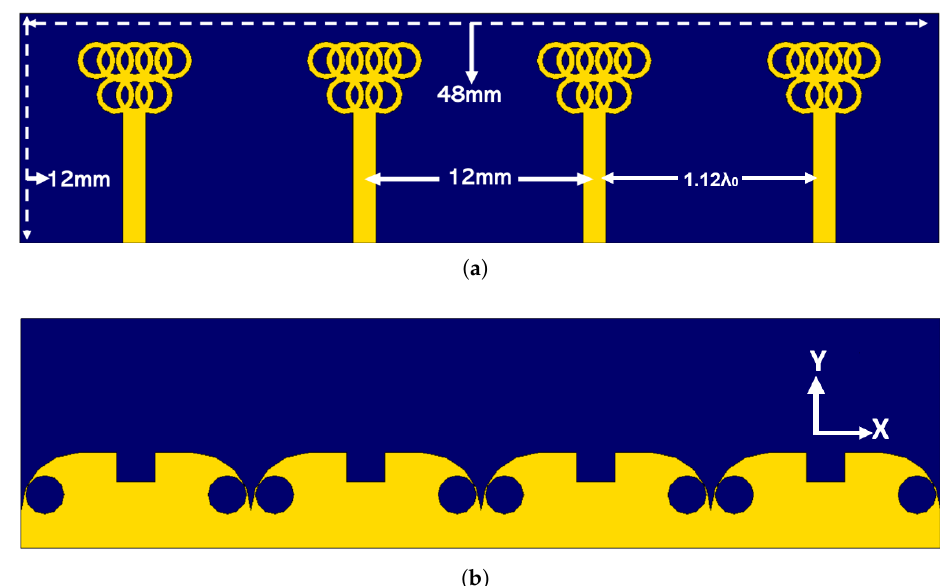
Figure 7. Olympeak MIMO antenna ( a ) front view ( b ) back view.